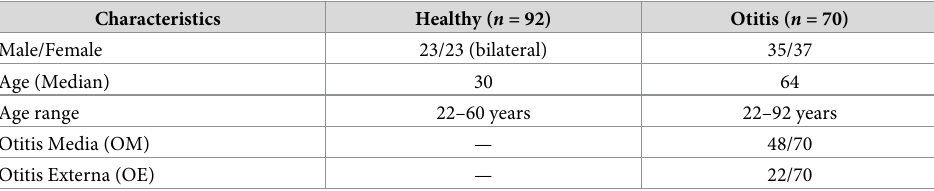
Table 1. Clinical characteristics of study